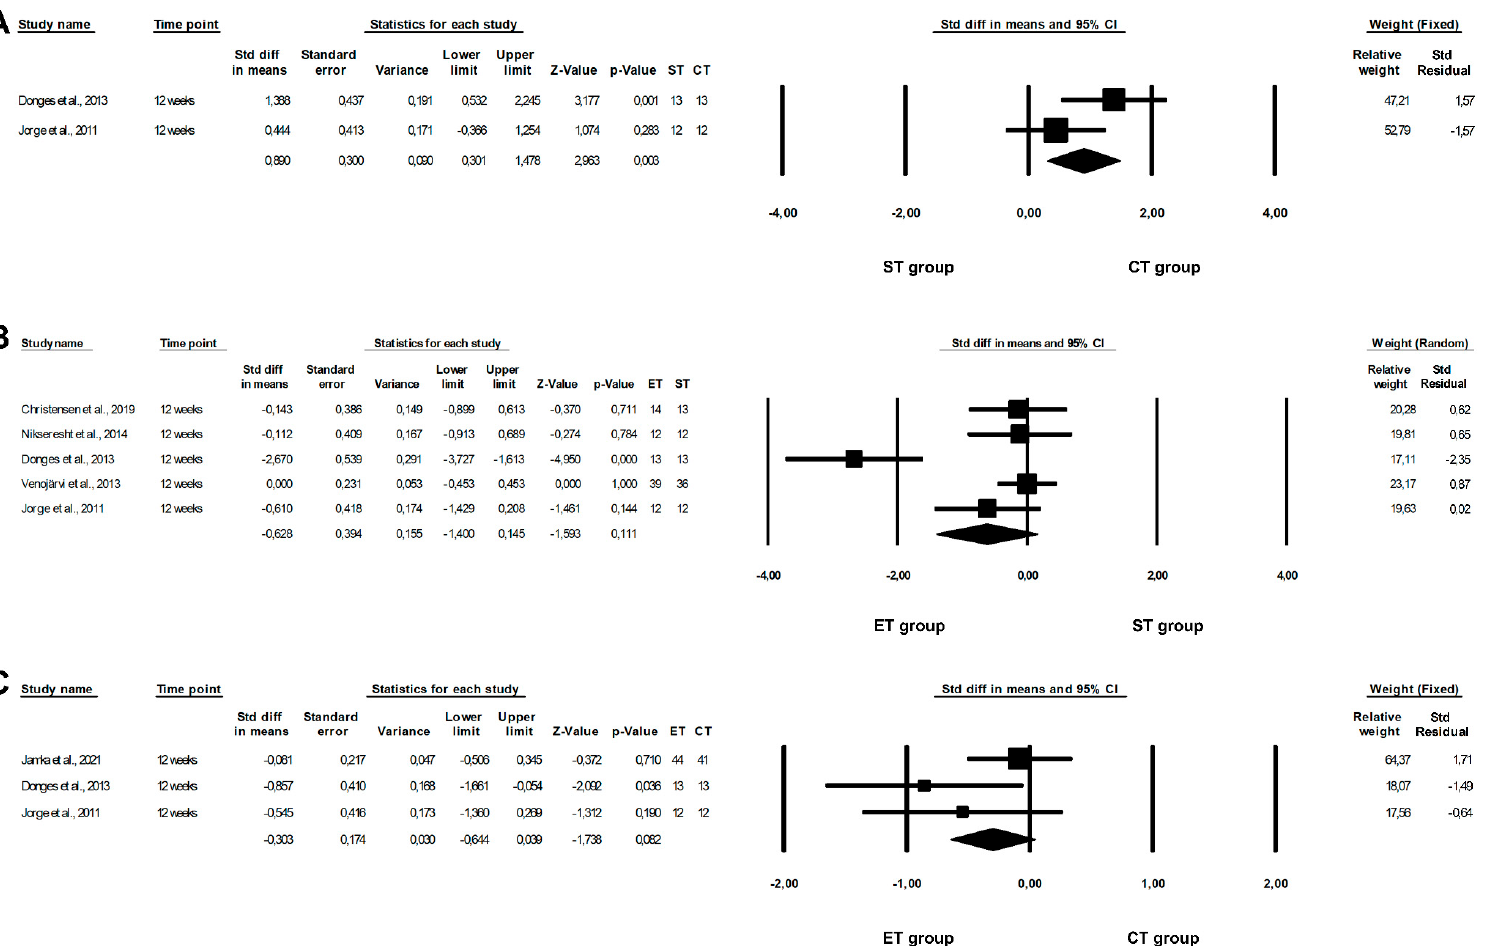
Figure 4. Forest plots of the effect of different training programmes on TNF- α levels: ( A ) ST vs. CT—fixed model; ( B ) ET vs. ST—random model; ( C ) ET vs. CT—fixed model. CI—confidence interval; CT—combined training; ET—endurance training; ST—strength training; Std diff—standard differences [16,21,23,25,38,40].